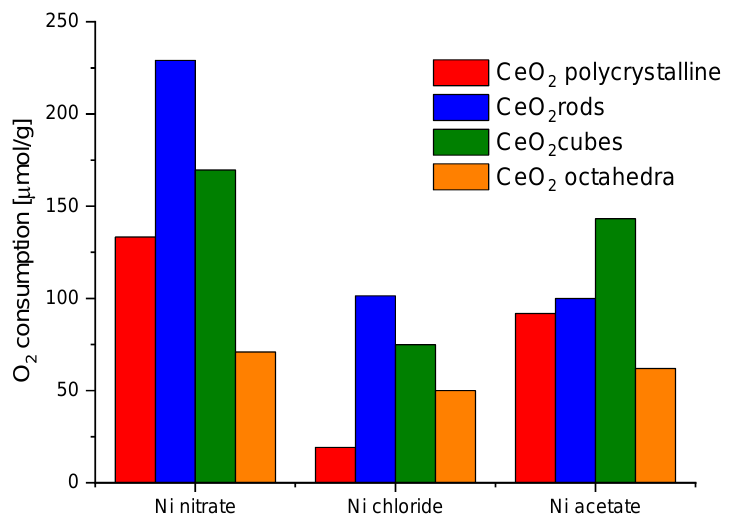
Figure 8. Oxygen consumption from CO 2 pulse chemisorption of CeO 2 cubes and CeO 2 rods decorated with different metals and prepared by different methods.